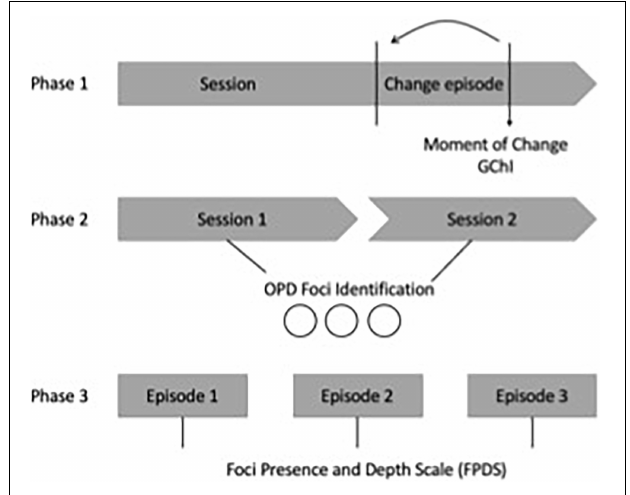
FIGURE 1 | Phases of the